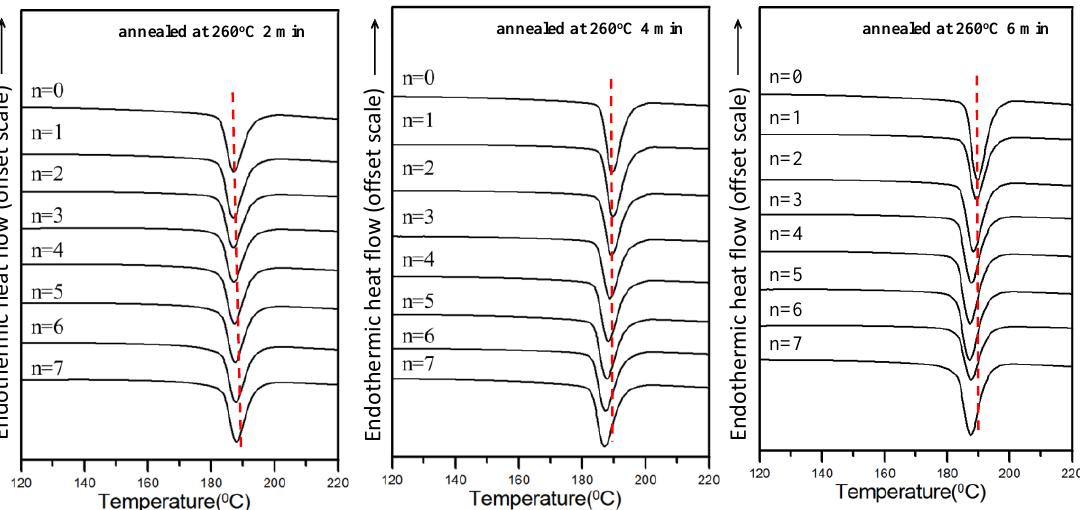
Figure 10. DSC traces of of phenoxy/PBT = 1/9 samples after cycles of annealing at 260 °C for various periods of time followed by cooling.